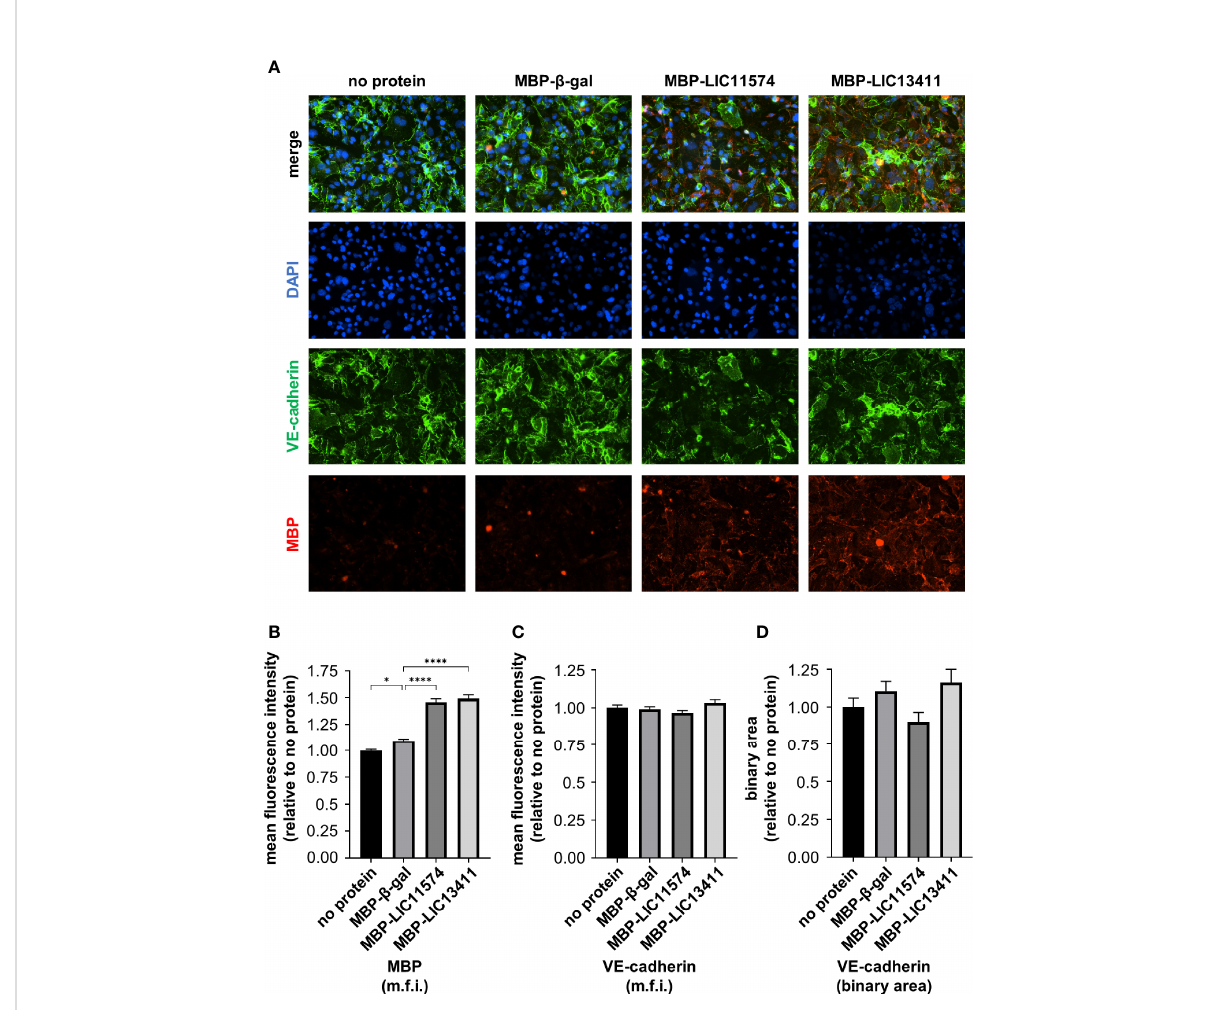
FIGURE 2 Adhesins from L. interrogans bind endothelial cells. HMECs were grown to con fl uence on glass slides and treated with puri fi ed MBP-adhesin fusions for 1 h. Slides were stained for VE-cadherin (green) and MBP (red), and mounted with Prolong Diamond Antifade Mountant with DAPI (blue). (A) MBP-adhesin fusions bind to endothelial cells in a pattern reminiscent of VE-cadherin; however, little overlap is seen. (B) M.f.i. of MBP was quanti fi ed. MBP-adhesin fusions bind to cells signi fi cantly more than cells treated with MBP- b -gal control and signi fi cantly over background signal from untreated cells. (C) M.f.i. of VE-cadherin was quanti fi ed. Total VE-cadherin staining does not change with MBP-adhesin treatment. (D) Binary areas of VE-cadherin in AJs were determined. No change in VE-cadherin localized to AJs is seen with puri fi ed MBP-adhesin treatment. Data represent three independent experiments; 10 images per slide were taken and analyzed quantitatively for each experiment. Mean ± SEM is plotted. Each column is compared to the MBP- b -gal control. *denotes p ≤ 0.05, ****denotes p ≤